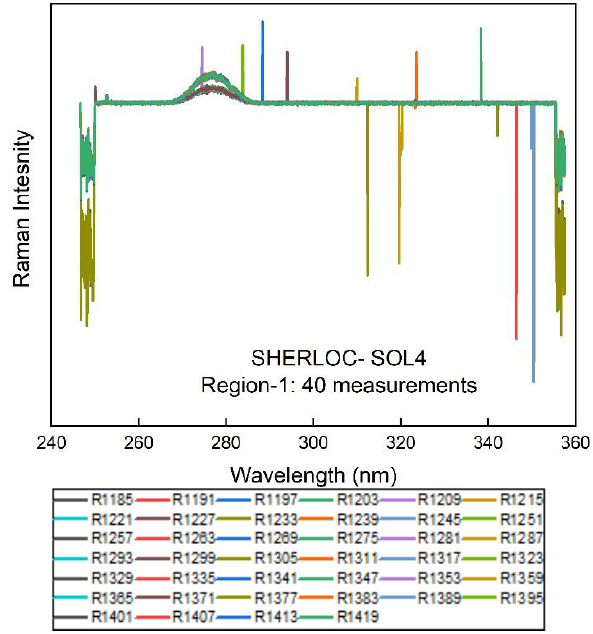
Figure 4 . SHERLOC measurements for Sol 4 (Region-1)